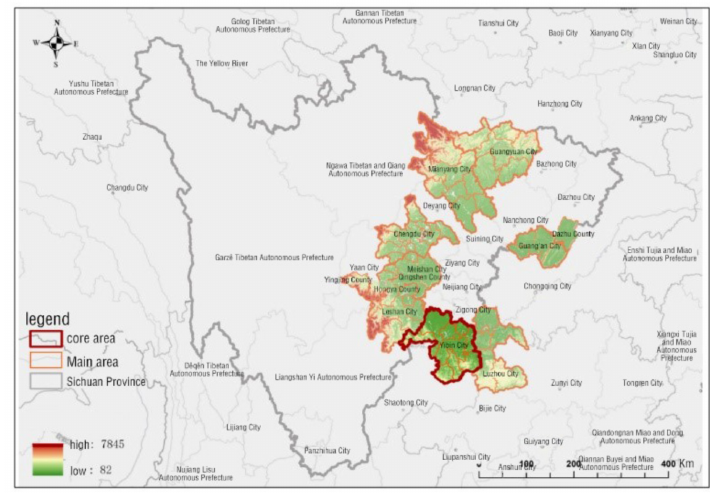
Figure 5. Elevation analysis of research areas in Sichuan Province.